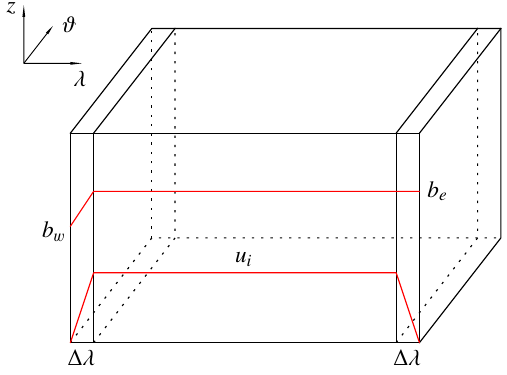
Fig. 1. Envisioned basin geometry and zonal structures of buoyancy and zonal velocity as assumed in the model. Note that the spherical geometry of the model is not represented in this